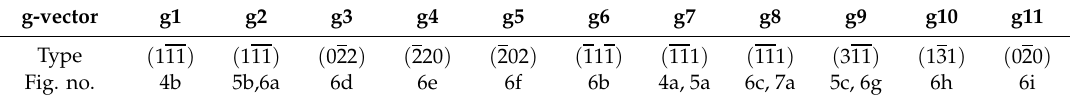
Table 2. The operating diffraction vectors used in this work with the appropriate figure numbers for conditions shown in the last row. Note that in Figure 5c the condition minus g9 is used.